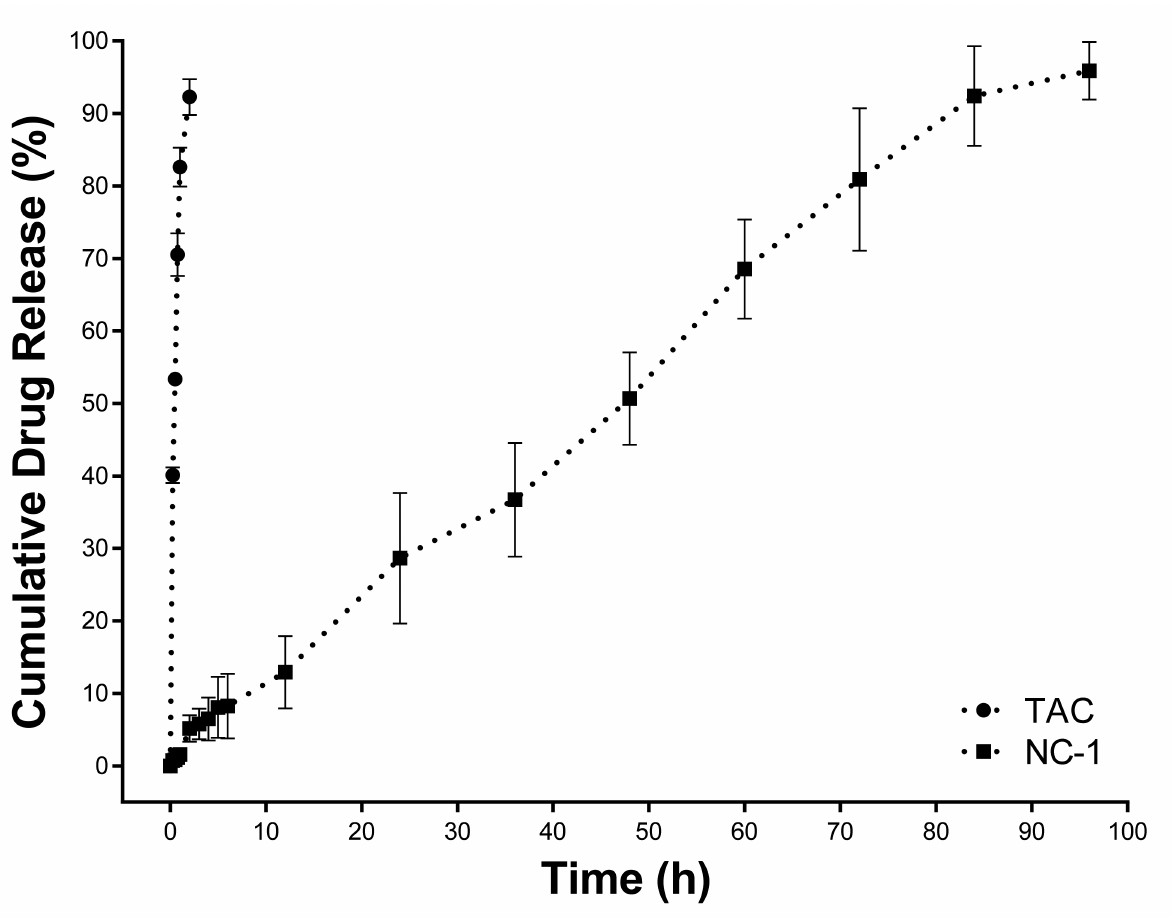
Figure 6. In vitro TAC release profile for free drug and TAC-loaded nanocapsules